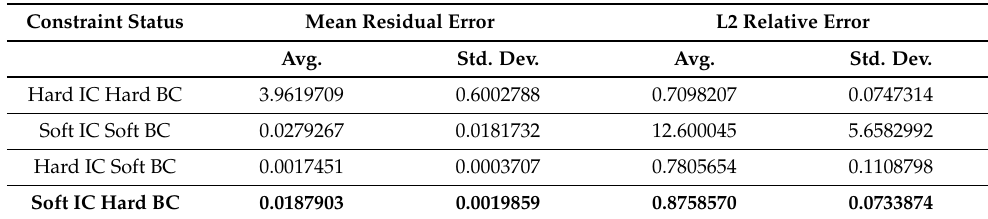
Table 4. Error evaluation of using the best-tested set of hyperparameters in a soft IC constraint and hard BC constraint (soft–hard)